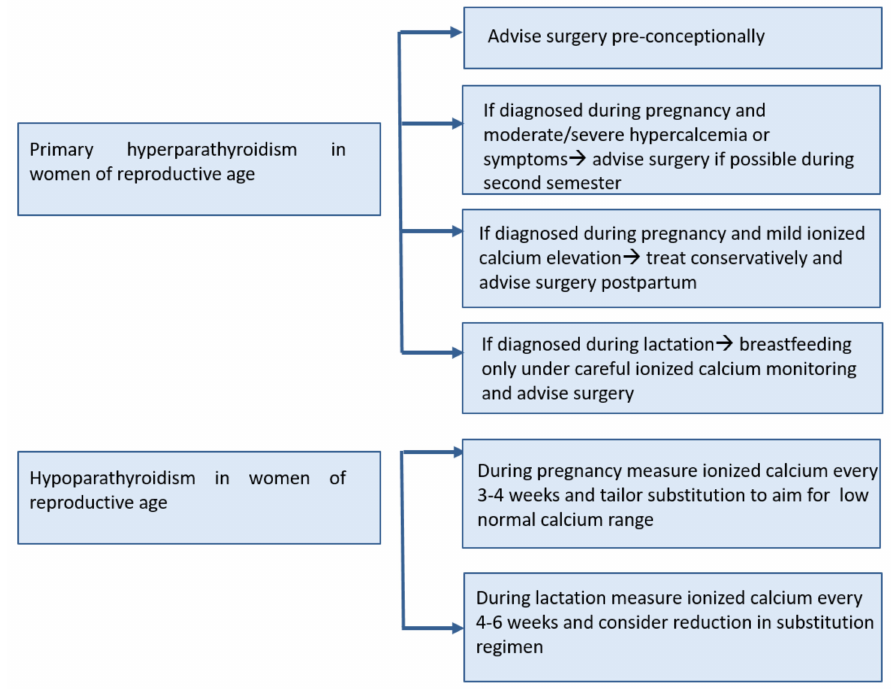
Figure 2. Management of parathyroid disorders during pregnancy and